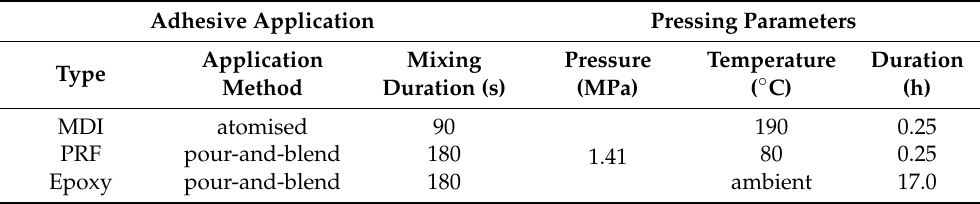
Table 3. Ultra-low-density hemp particleboard fabrication parameters.